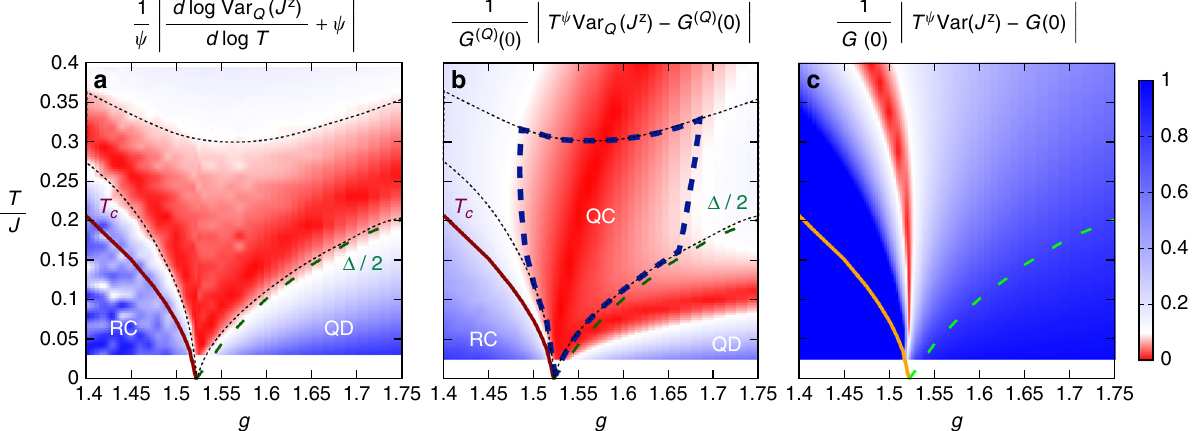
Fig. 3 Reconstruction of the quantum critical fan of the 2d TFI model via the quantum variance. a Relative deviation of the logarithmic derivative of the order-parameter QV from the QC scaling exponent ψ — the data shown have been obtained for a L = 64 lattice (uneven spots in the RC region are numerical artifacts). The solid and dashed lines indicate the critical temperature 53 and half of the spectral gap (extracted from the T scaling of 〈 S x 〉 ) respectively, while the dotted line marks the region with less than 10% deviation. b Relative deviation of Var Q ( J z ) T ψ from the QC amplitude G (Q) (0); same symbols as in ( a ). The dashed blue line encircles the region with less than 10% deviation on both the prefactor and on the logarithmic derivative. ( c ) Relative deviation of Var( J z ) T ψ from the QC prefactor G (Q) (0); other symbols as in ( a